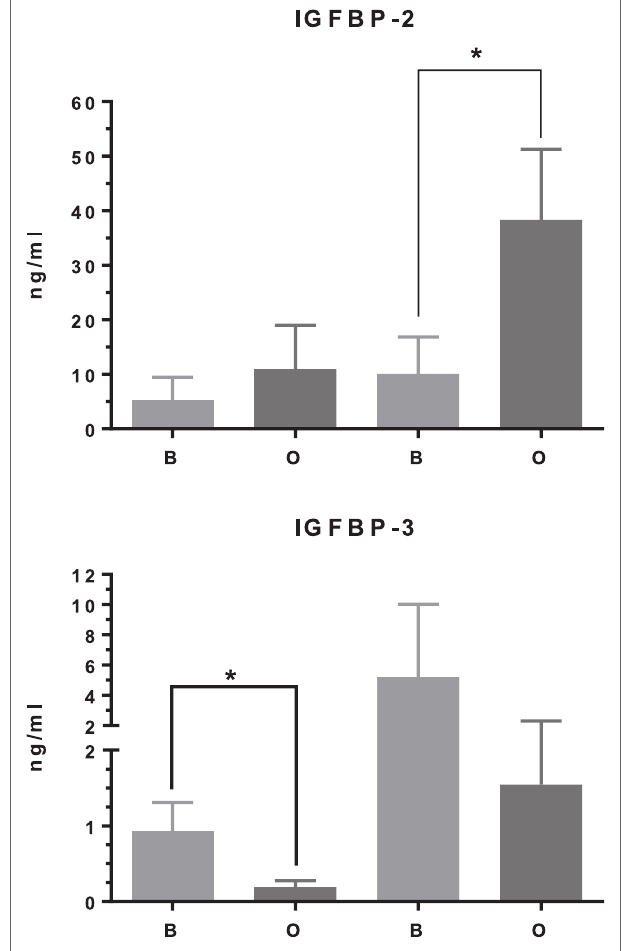
FigUre 2 | IGF binding protein (IGFBP)-2 and IGFBP-3 protein concentration in cDPC cultured under basal or mineralizing conditions. Media was conditioned by cells from three separate donors grown under basal or osteogenic conditions at both 1- and 3-week time points. Assays were performed as technical triplicates for each donor and are presented as mean ± SEM ( n = 7–9) in nanogram per milliliter for each protein(* p